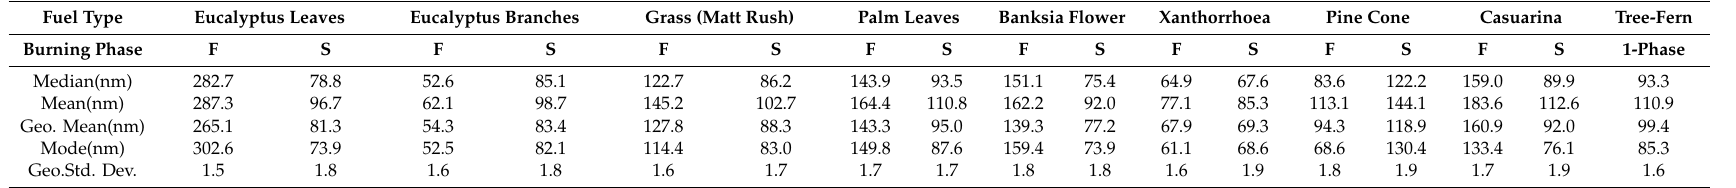
Table 1. Particle statistics information provided by SMPS for smoke particles of the flaming (F) and smouldering (S) phases. Values are averages of at least six replicates. Standard deviations for geometric mean diameter values are within the 10–20 nm